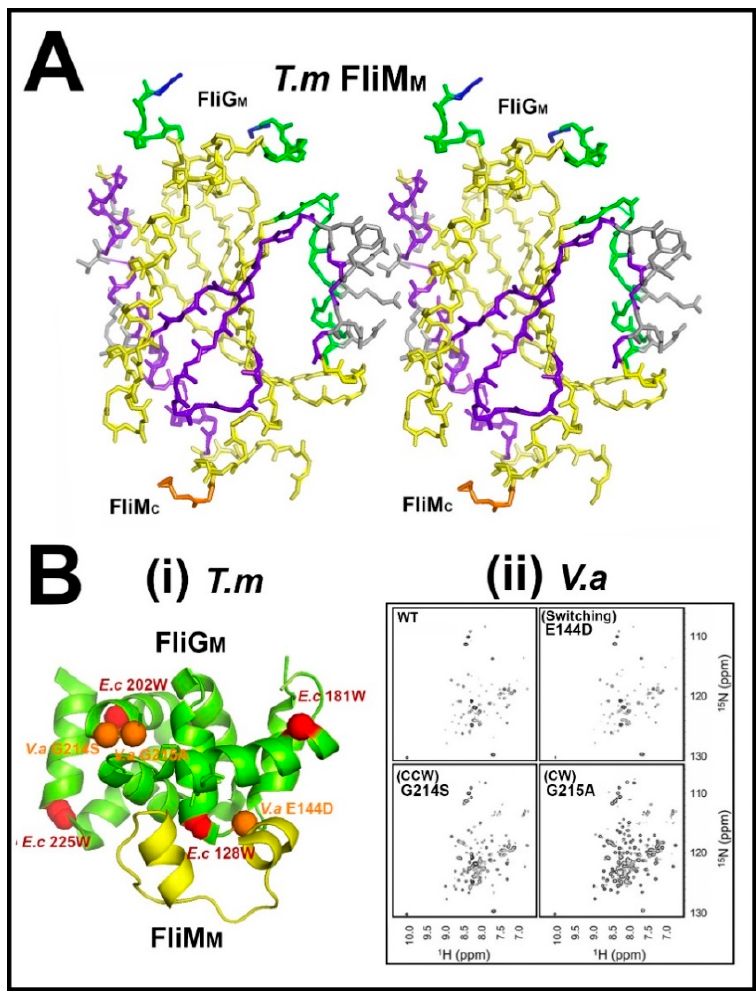
Figure 3. The central signal processing unit. ( A ) FliM M dimer model. The model is based on the T. maritima FliM M structure (gold)) guided by in situ cross-link data (grey). Localized CW (green) and CCW (magenta) biasing residue substitutions from bacterial homologs are mapped onto the colored structural elements. FliG GXXG interaction loop (blue). C-terminus (orange) (PDB: 2hp7 (modified from ([76])). ( B ) The central processing interface—FliG M -FliM M . ( i ) T. maritima structure (PDB: 4fhr) highlighted with homologous FliG M residues to those implicated by E. coli tryptophan mutagenesis (red [82]) and V. alginolyticus switch mutants G214S, G215A and E144D (orange [83]). ( ii ) 2D-NMR